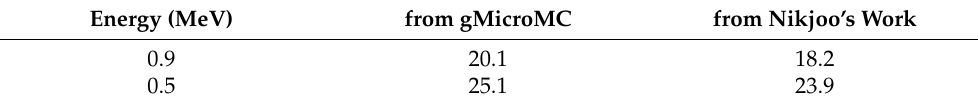
Figure 5. A representative track structure for a 5 MeV proton at the entrance part ( a ) and in the Bragg peak region ( b ). The proton was emitted along the positive Z direction. Red and blue dots represent the energy depositions by the proton and secondary electrons, respectively. Note: in the two subplots, we kept the same aspect ratio between the z and x/y axes, but plotted them with different ranges. Table 4. The DSB yields (number per Gy per Gbp) obtained under the overlay method for two proton